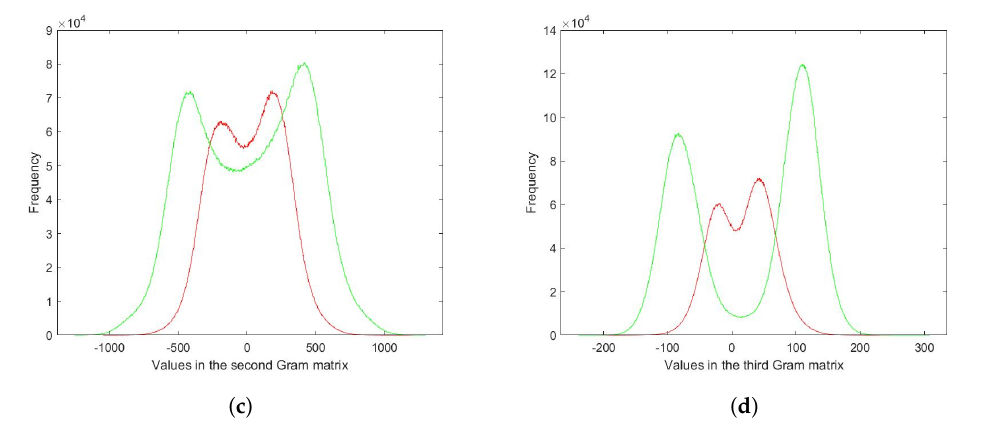
Figure 12. Histogram of fingerprint images ( a ) and three Gram matrices (( b )–( d )) (red: live, green: fake).